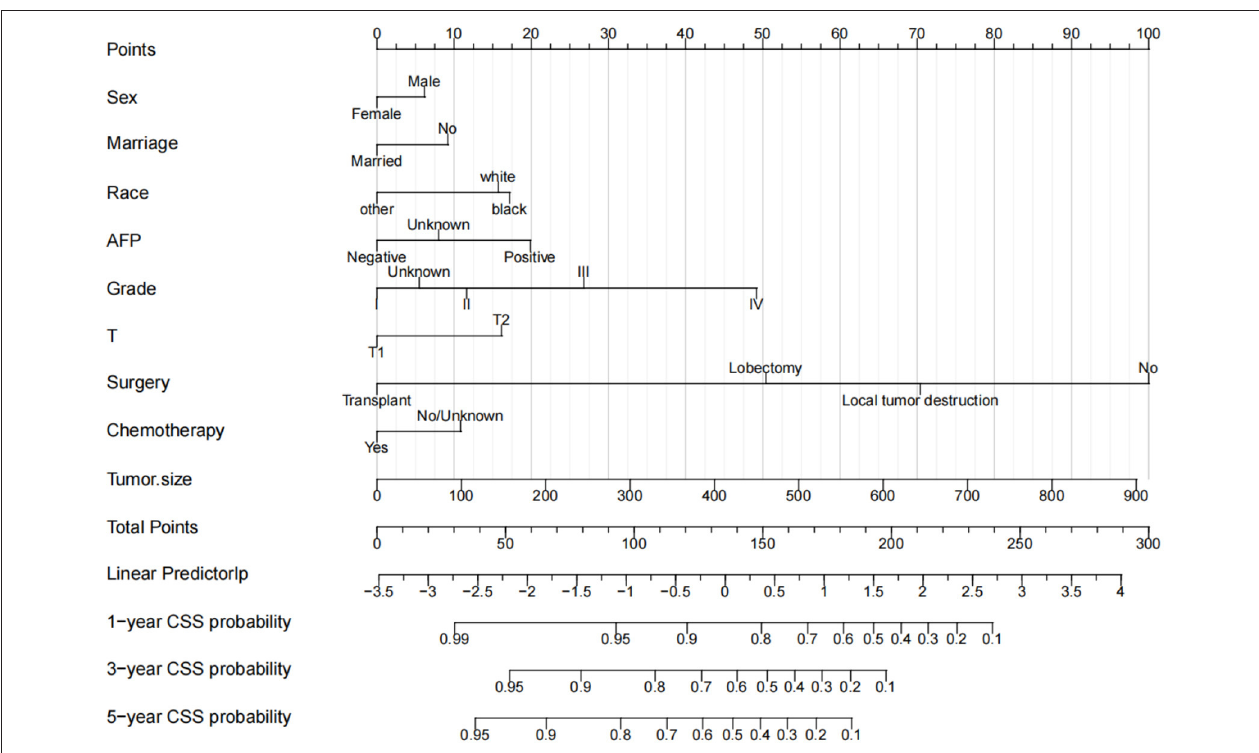
FIGURE 2 | The nomogram of CSS in middle-aged patients with HCC at 1-, 3-, and 5-year.